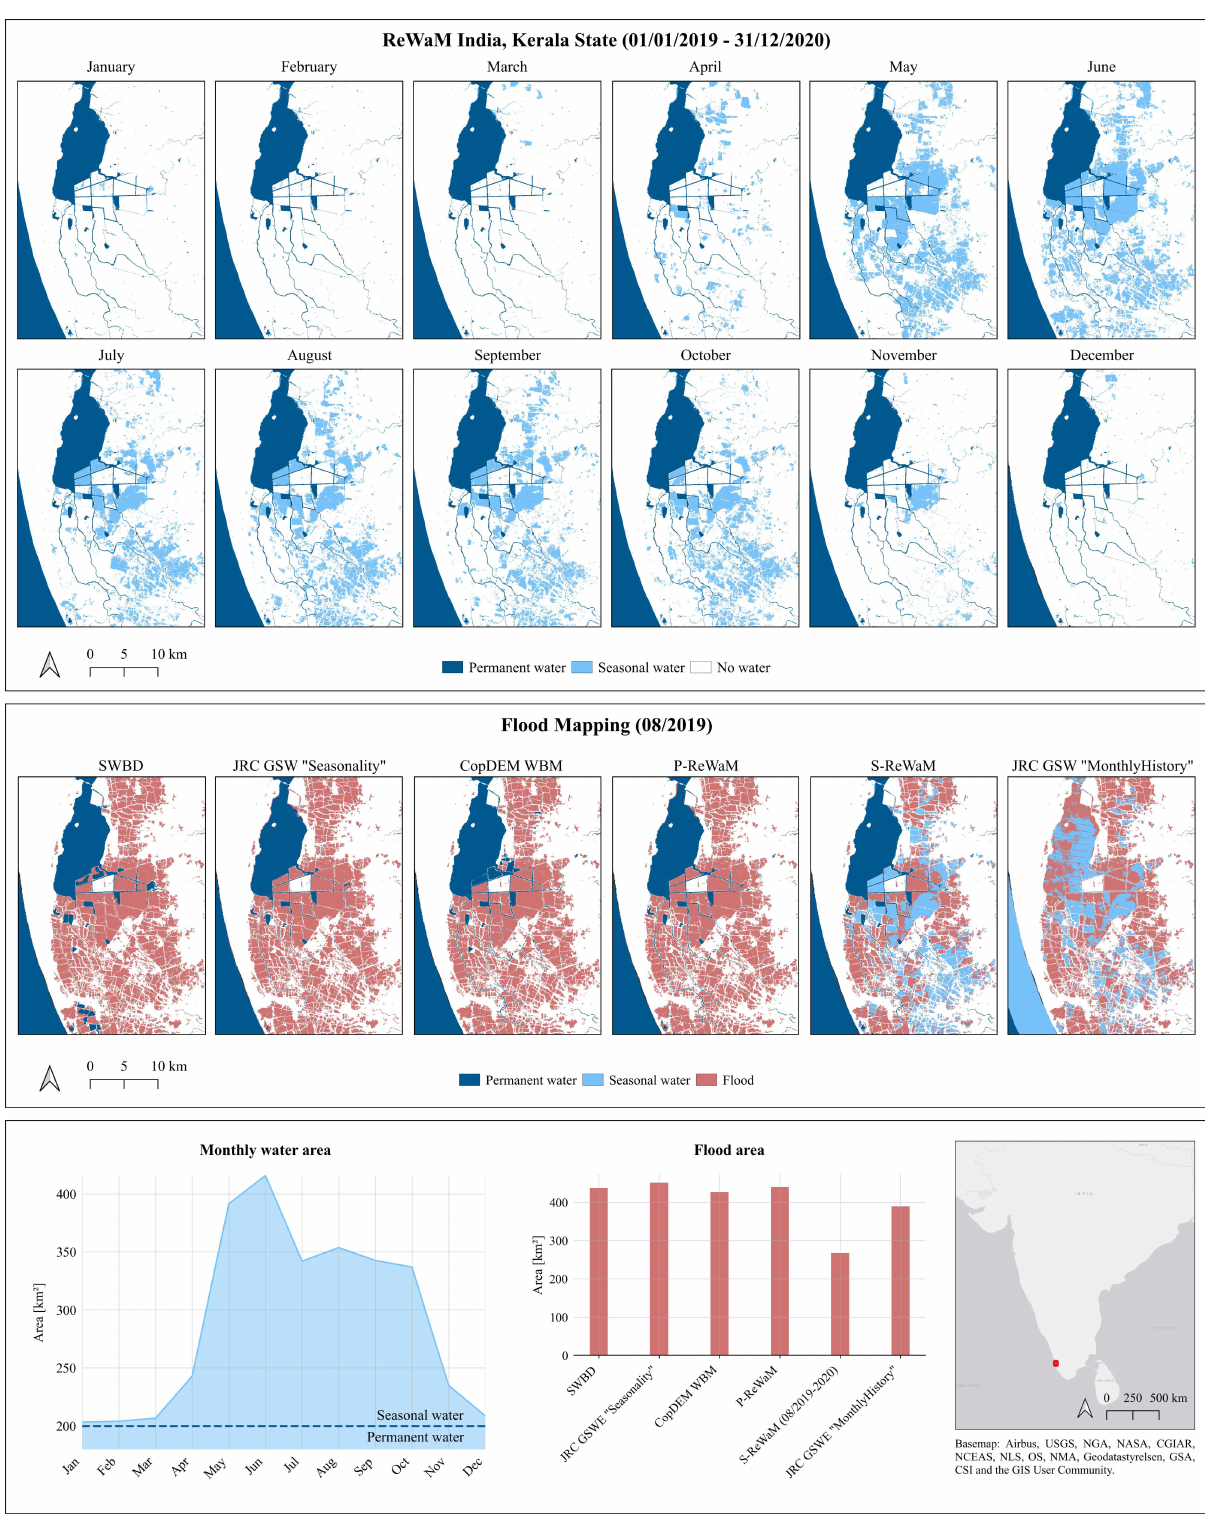
Figure 4 . Reference water extents of P-ReWaM and S-ReWaM for the study area in India, Kerala State, derived from Sentinel-1/2 time-series data (observation period: 01/01/2019-31/12/2020). Comparison of flood mapping results in India using P-ReWaM and S- ReWaM with external reference water masks; flood extents are derived from Sentinel-1 data acquired during a real flood event in August 2019. The S-ReWaM of the month August is used as seasonal reference water mask. Corresponding flood extents are visualized as bar